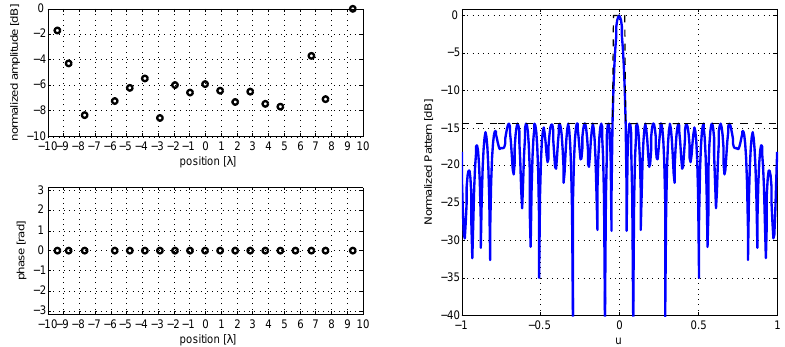
Figure 3. The achieved 19 element symmetric pencil beam layout. On the left : normalized amplitude and excitation phase; on the right : pencil beam pattern with its upper mask.